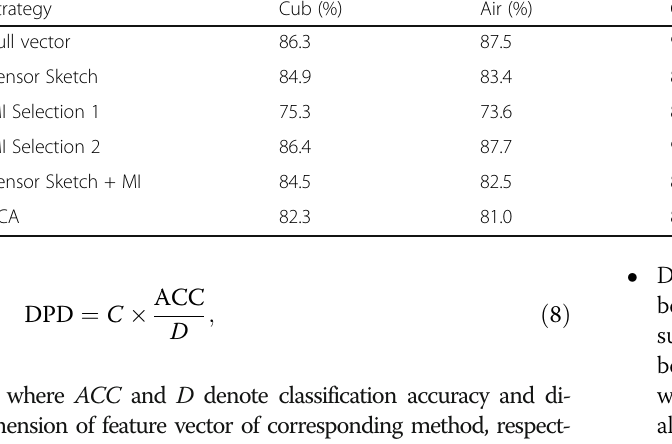
Table 4 Evaluation of dimension reduction. For dogs, we use AlexNet and thus the dimension of full vector of this is 49,152 Strategy